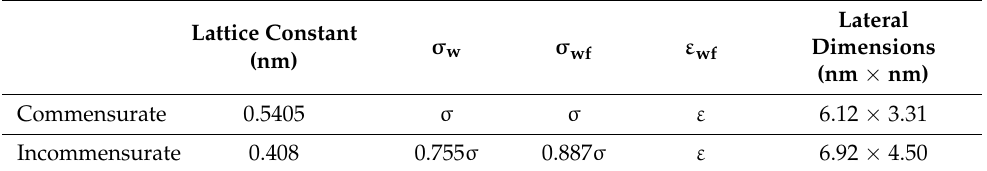
Figure 1. Schematic of the simulation model. Commensurate contact: ( a ) the adsorption branch started with an empty box and ( b ) the desorption branch started with a full box. Incommensurate contact: ( c ) the adsorption branch started with an empty box and ( d ) the desorption branch started with a full box. Atoms in face-centered cubic (FCC), hexagonal close-packed (HCP), body-centered cubic (BCC), and other mixed crystalline structures are in green, red, purple, and white, respectively. The color scheme is consistent throughout this work. Table 1. The relevant parameters for commensurate and incommensurate contacts used in this study.